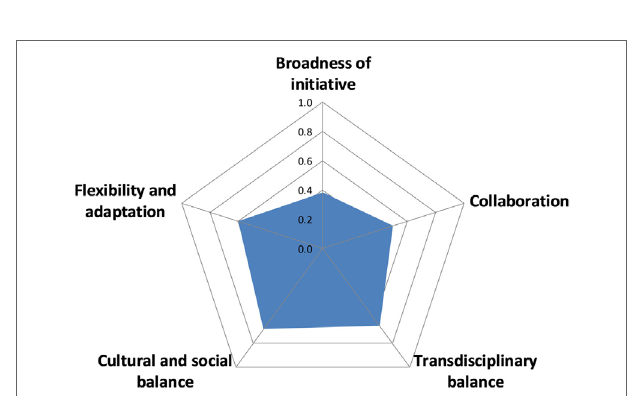
FigUre 10 | Assessment of learning infrastructure in the Southern African Centre for Infectious Disease Surveillance.